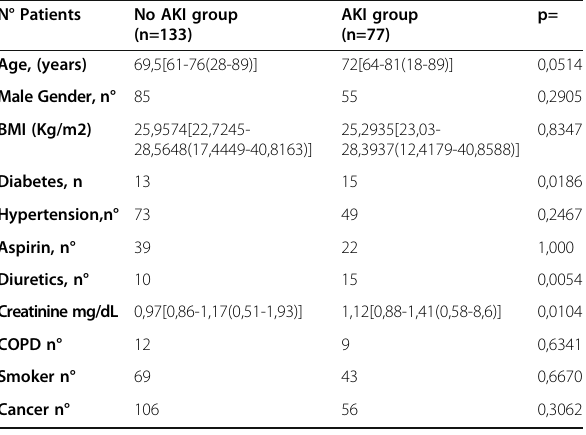
Table 1 (abstract A11). Demographical and clinical characteristics of the patients N°